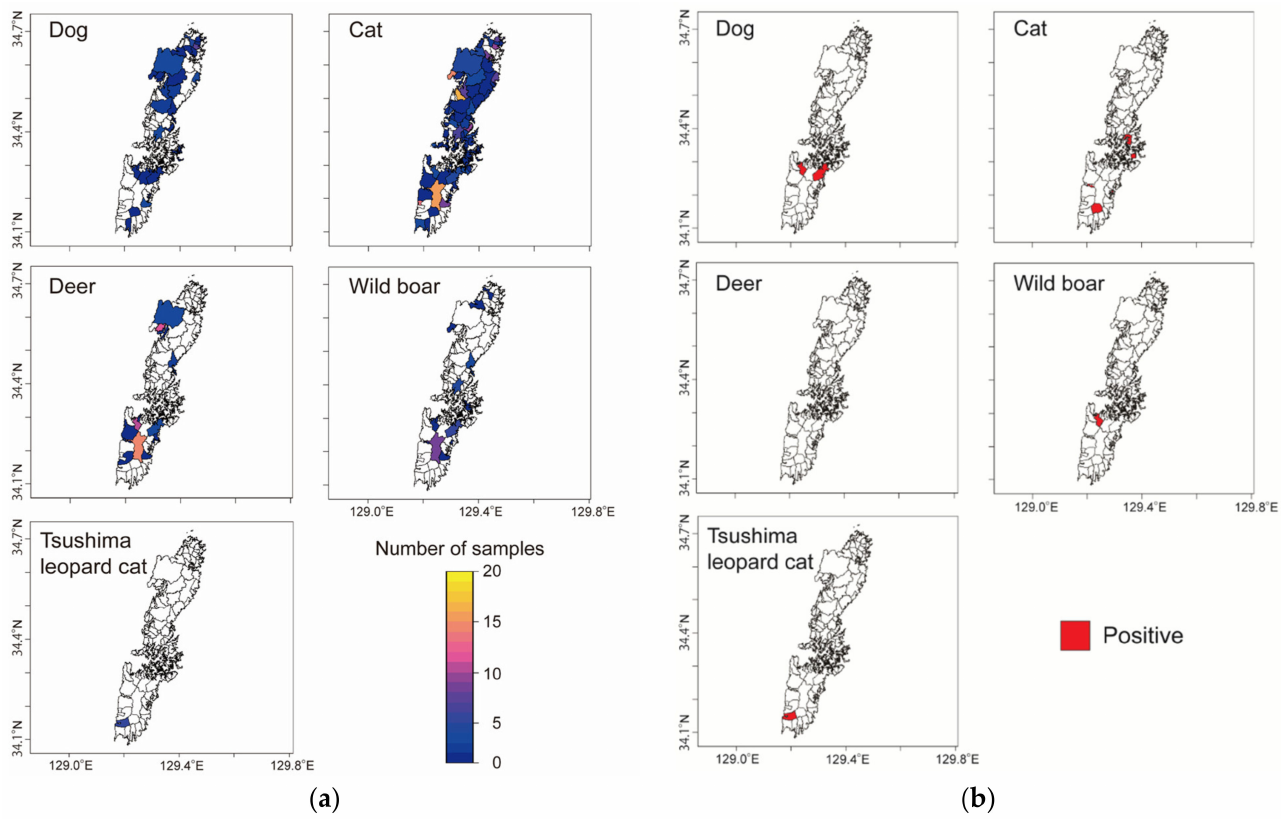
Figure 2. Sites at which animal samples were collected ( a ) and locations of SFTSV‑positive ani‑ mals ( b ), depicted using a geographical information system (GIS) based on geo‑coordinates using QGIS software, version 2.12.3 (QGIS.org, QGIS Geographic Information System. QGIS Association; http://www.qgis.org, 2021) and R statistical software (R version 4.2.1., R Core Team